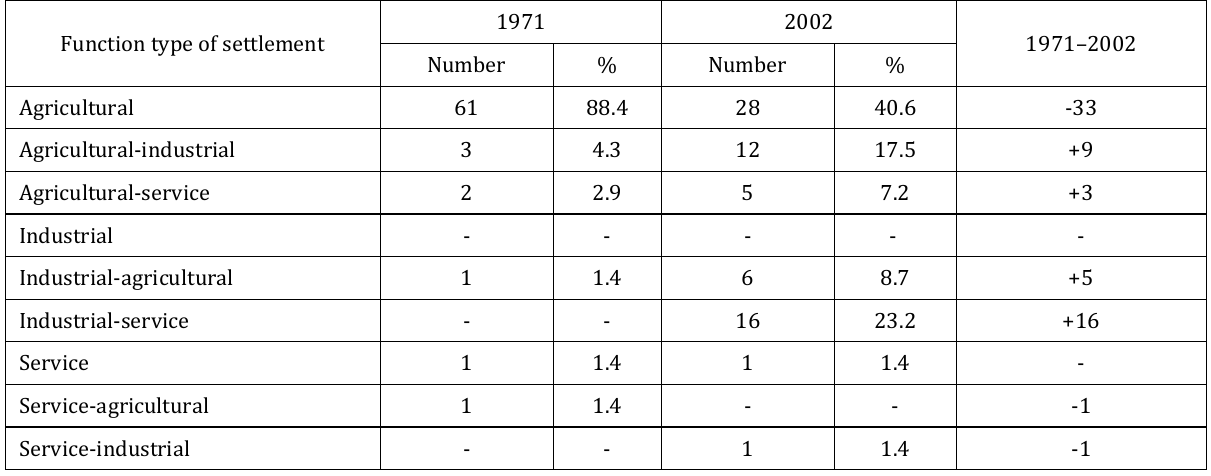
Table 4. Changes of functional types of Serbian settlements between 1971–2002 Function type of settlement